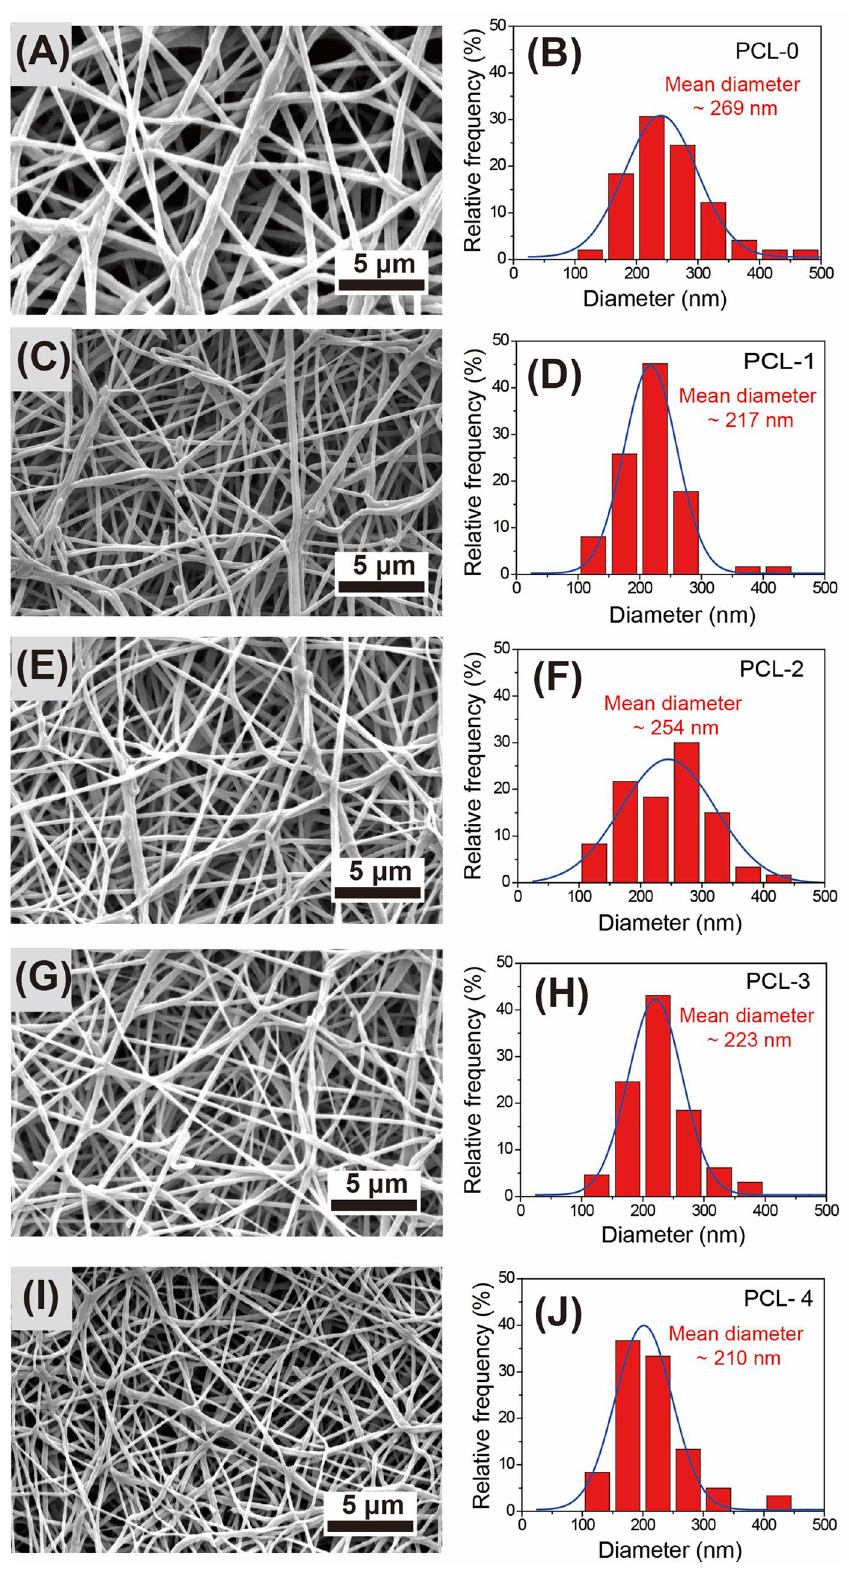
Figure 3 . SEM images of electrospun PCL based nanofibrous membranes and measured fiber diameter distribution: (A,B) PCL-0, (C,D) PCL-1, (E,F) PCL-2, (G,H) PCL-3, and (I,J)